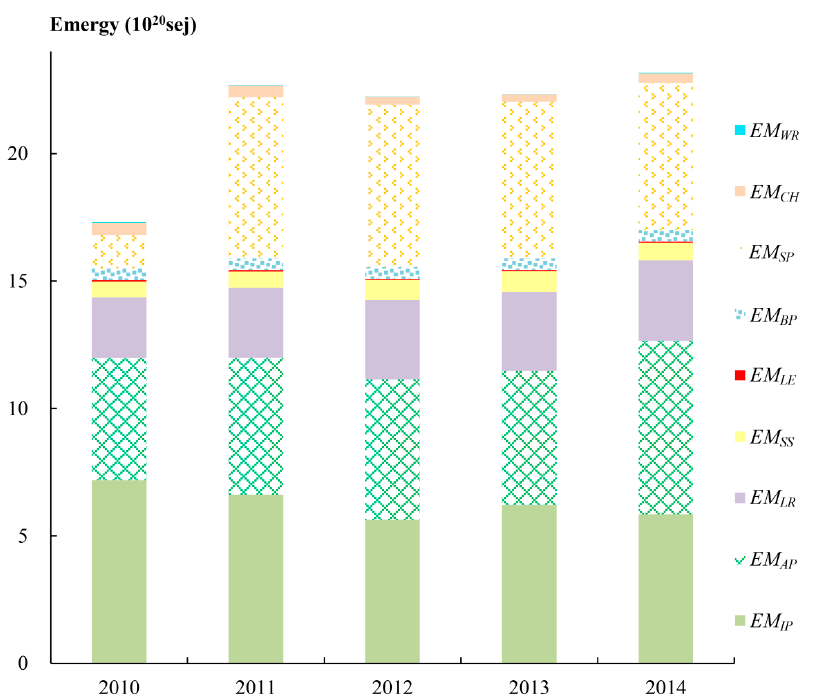
Figure 5. Annual variation of emergy of freshwater ecosystem services for Xuchang, Qingyi River Basin, from 2010 to 2014. For emergy abbreviations see Section 2.3.1. Table 1. Emergy of freshwater ecosystem services in Qingyi River Basin of Xuchang from 2010 to 2014.